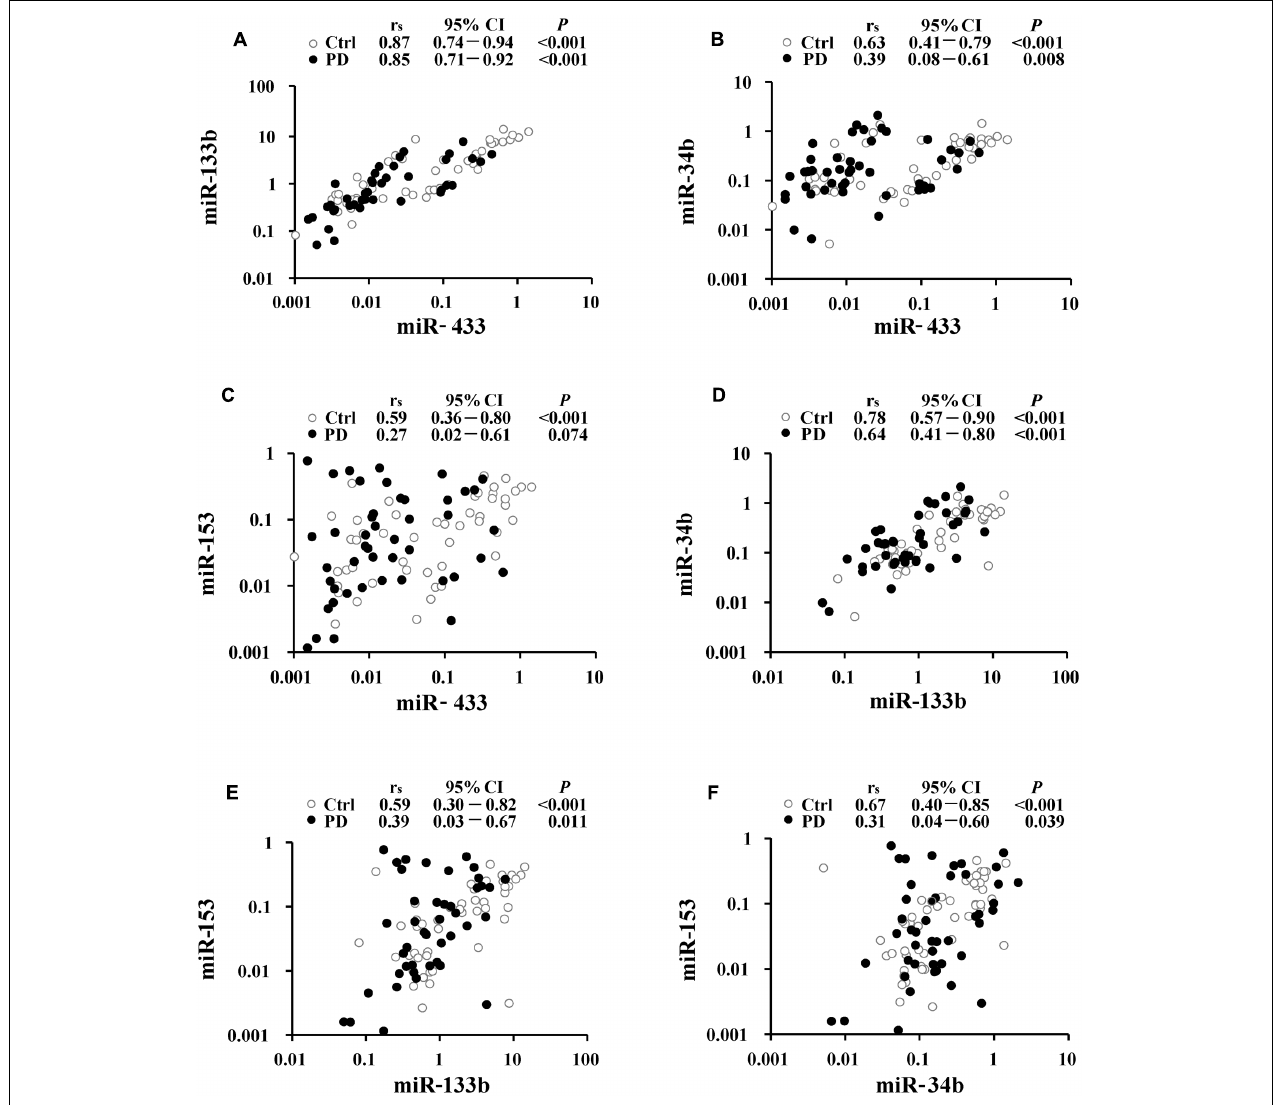
FIGURE 2 | Correlation analyses between miR-433 and miR-133b (A) , miR-433 and miR-34b (B) , miR-433 and miR-153 (C) , miR-133b and miR-34b (D) , miR-133b and miR-153 (E) , as well as miR-34b and miR-153 (F) in Parkinson’s disease (PD) and control (Ctrl) groups. Spearman’s rank correlation coefficient ( r s ) along with 95% confidence intervals (CI) and P -values are listed above each